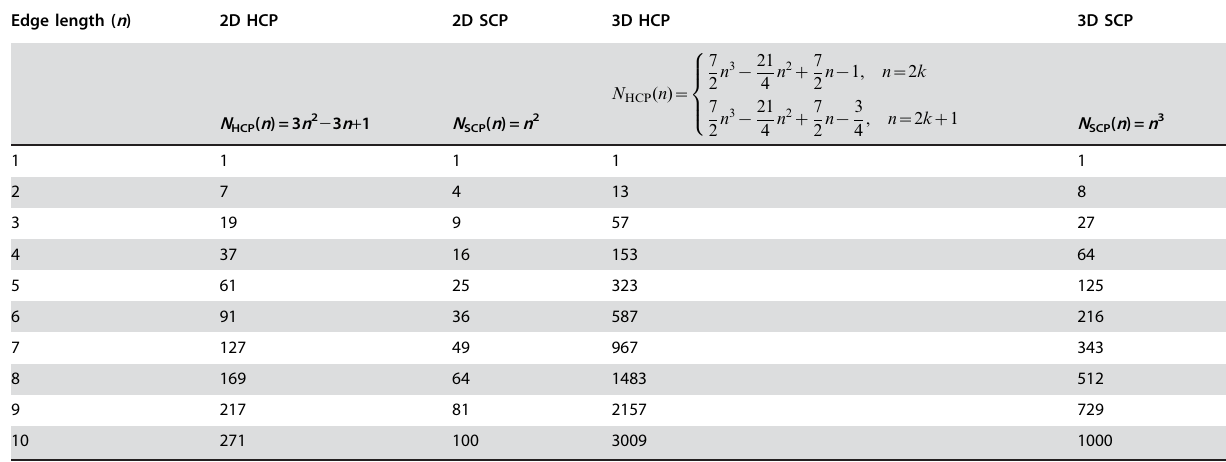
Table 3. Number of cells that can be packed in HCP and SCP clusters .. ... .... ... ... .... ... ... .... ... ... .... ... ... .... ... ... .... ... ... .... ... ... .... ... ... .... ... ... .... ... ... .... ... ... .... ... ... .... ... ... .... ... ... . Edge length